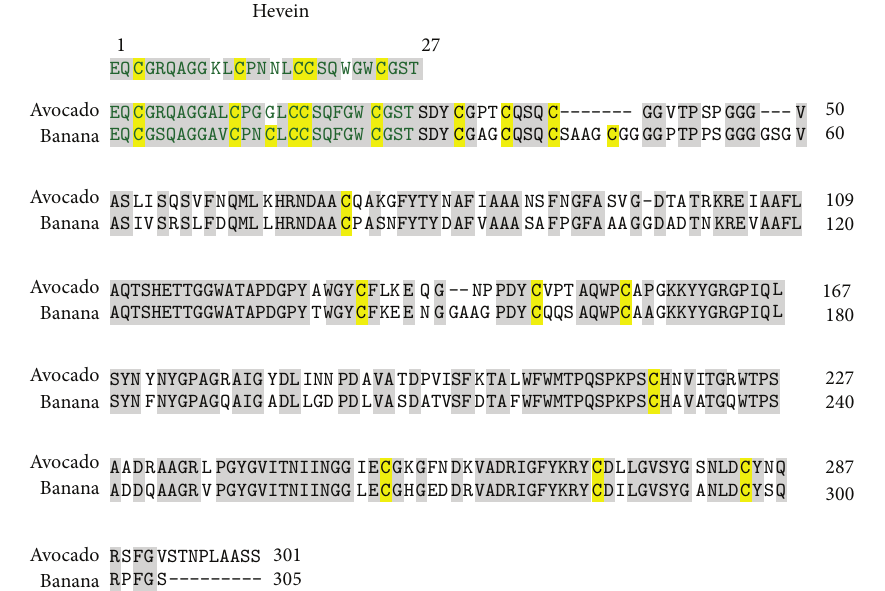
Figure 4: Sequence alignment of chitinase I from avocado (Pers a 1) and banana. The hevein-like domain (matching with sequence of hevein (1–27)) has also been marked in green. The identical residues and the cysteine residues are highlighted in grey and yellow,